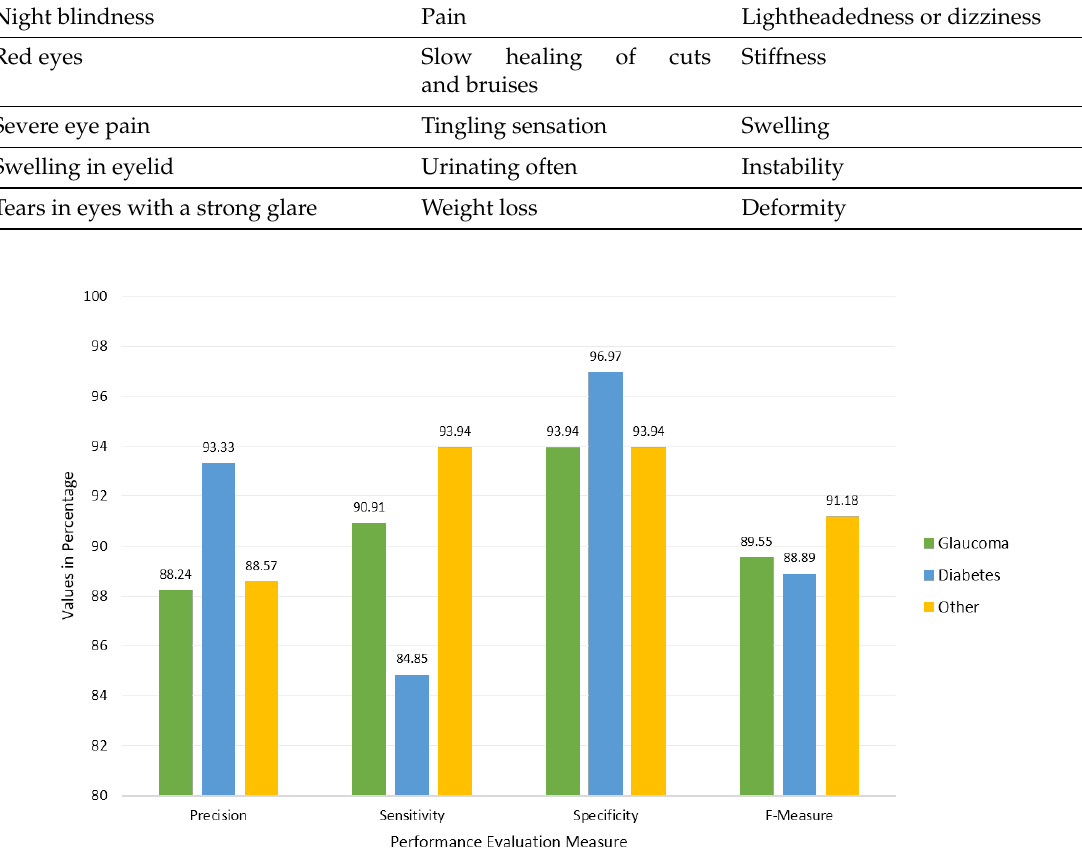
Figure 7. Performance evaluation measure of interactive